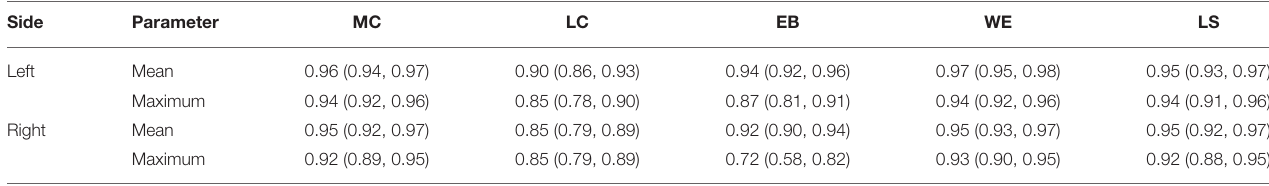
TABLE 2 | Concordance correlation coefficients (95% confidence interval) of replicated infrared imaging measures (mean and maximum temperatures) taken from the left and right eyes, respectively.